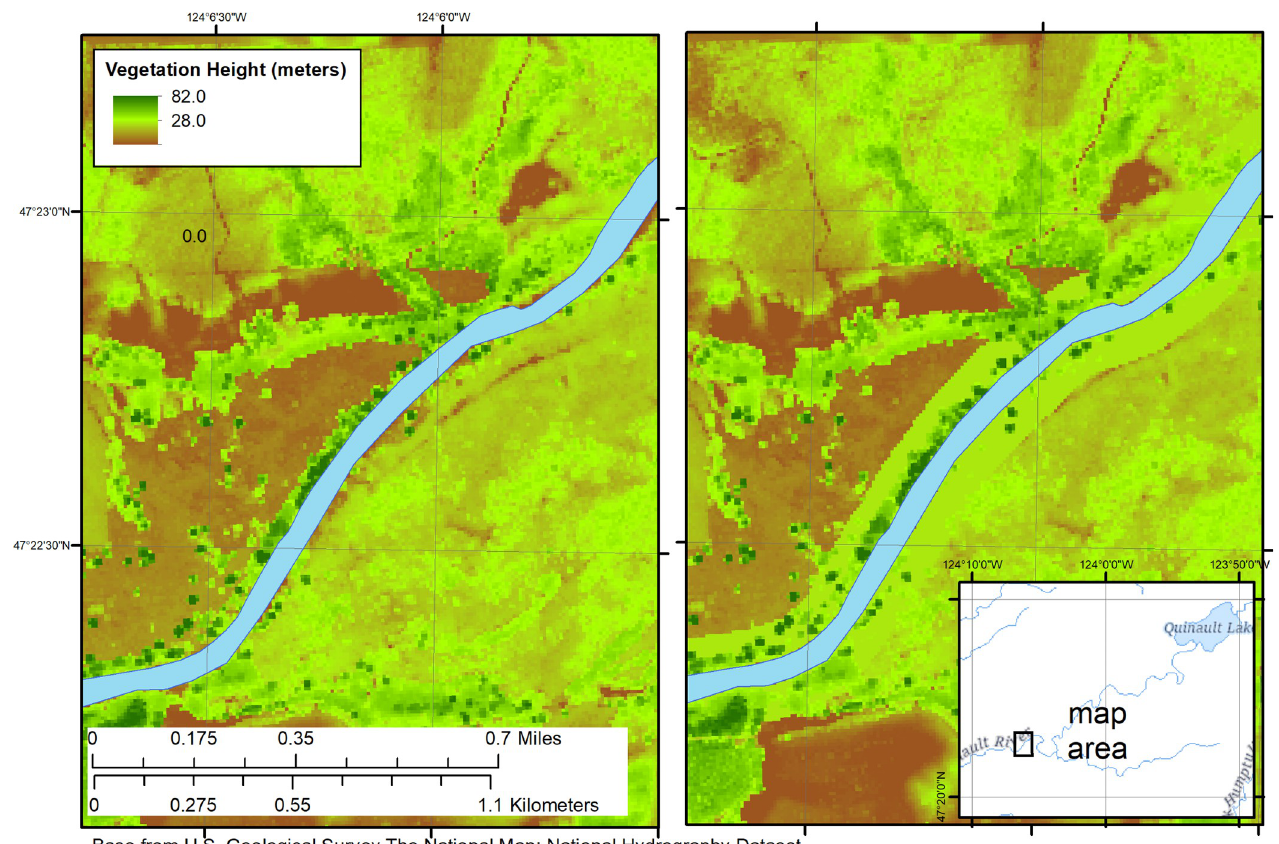
Fig 3. Example of riparian vegetation addition of nearshore river buffer with increased vegetation heights (in meters). The left panel represents current vegetation height, and the right panel represents a minimum 24.4-meter (80 feet) tree height within a 100-meter buffer from the streambank. https://doi.org/10.1371/journal.pone.0266871.g003 PLOS ONE | https://doi.org/10.1371/journal.pone.0266871 May 20,